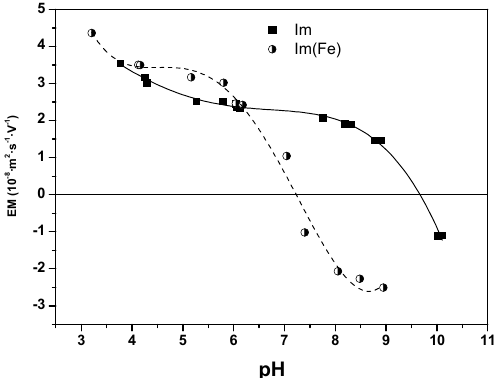
Figure 3. Electrophoretic migration vs. pH curves for Im (squares) and Im(Fe) (circles). EM, electrophoretic migration.